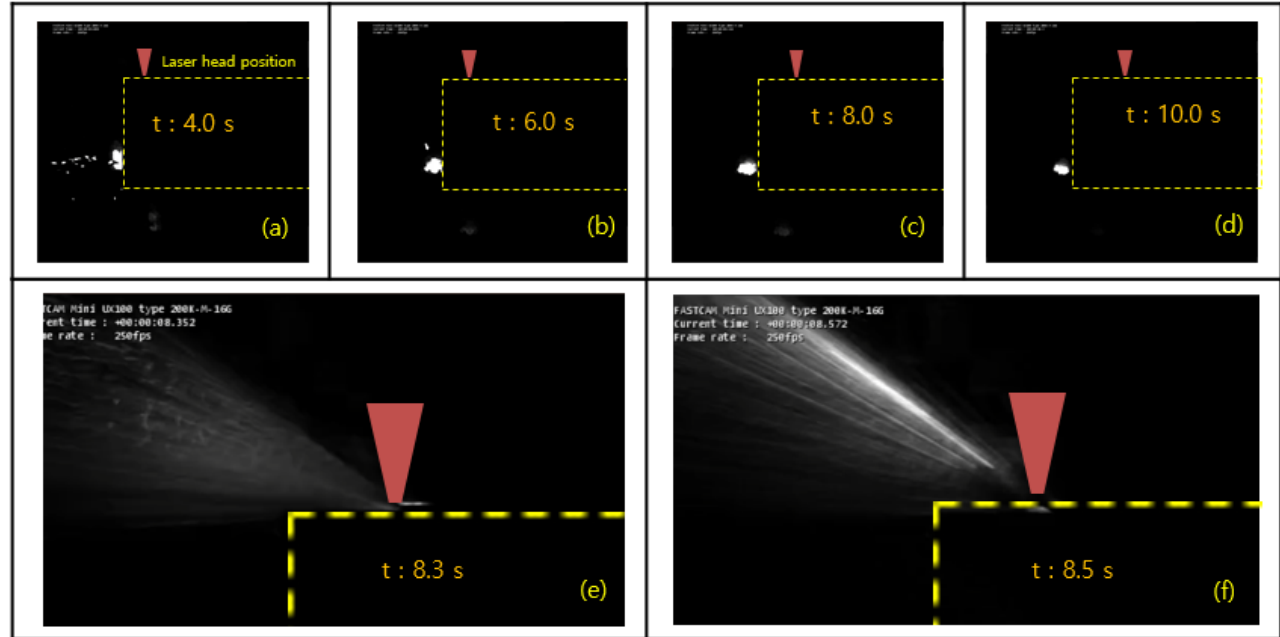
Figure 5. Molten pool behavior and evacuation captured by the high-speed camera in case 1 at ( a ) t: 4.0 s, ( b ) t: 6.0 s, ( c ) t: 8.0 s, ( d ) t: 10.0 s, ( e ) t: 8.3 s, and ( f ) t: 8.5 s.